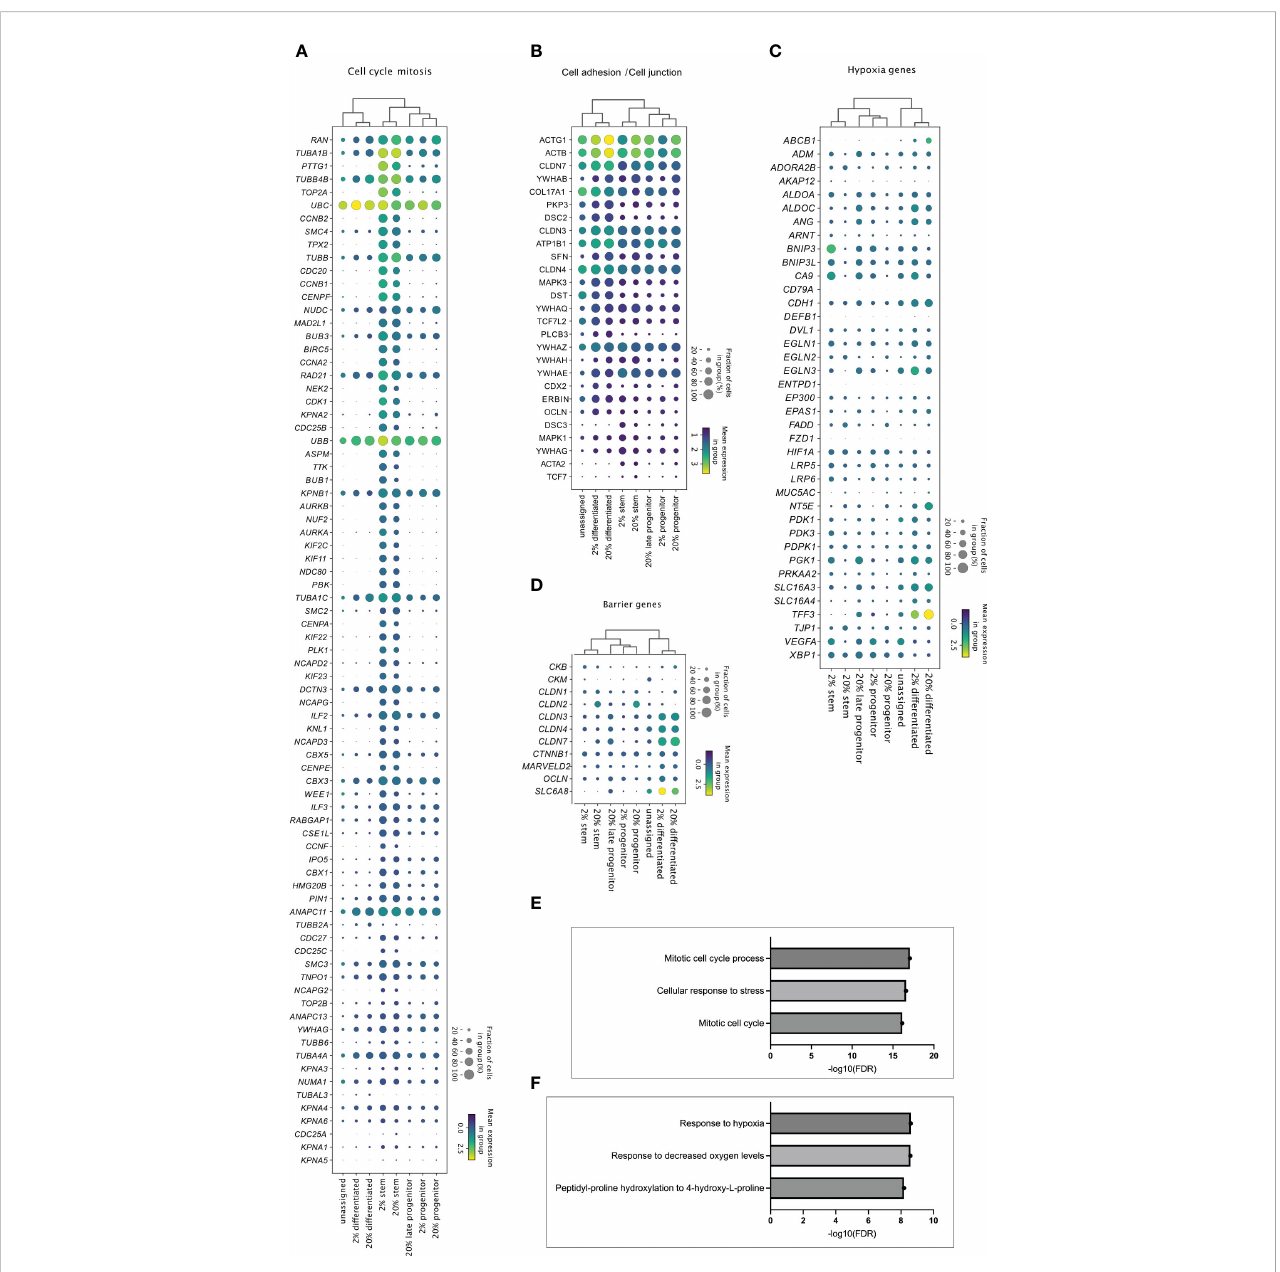
FIGURE 5 Cell cluster speci fi c transcriptome in 2% and 20% oxygen. Enrichment analysis of upregulated genes in the stem, progenitor, and differentiated cell clusters from 2% vs . 20% oxygen culture (adjusted P <0.05). were generated with MetaCore+MetaDrug ™ version 21.3 build 70600 (SF1, sheets 12-15). The dot plots display how (A) genes related to cell cycle and mitosis (A) , genes associated with cell adhesions and cell junctions (B) , hypoxia-related genes (C) and barrier genes (D) were expressed in the different cell type clusters. Cell clusters are listed along the x-axis, while genes are listed along the y-axis. The color intensity represents mean expression within a cluster, and the radius of the dot represents the fraction of cells in the cluster expressing a gene. (E, F) Bars indicate – Log10 false discovery rate (FDR), while the y-axis lists top three GO processes upregulated in stem-like cell clusters (E) and differentiated cell cluster (F) in 2% compared to 20% oxygen culture (Supplementary fi le SF1, sheets 14 and 15,